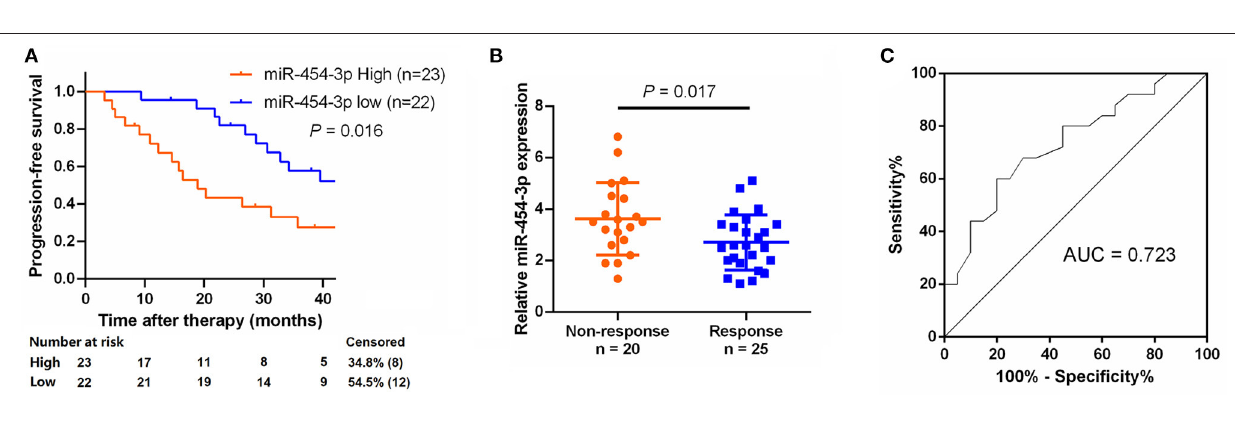
FIGURE 7 | Expression of miR-454-3p correlates with PFS in oxaliplatin treated colorectal cancer patients. (A) Colorectal cancer patients who received oxaliplatin-based chemotherapy were separated into groups based on low or high miR-454-3p expression. Kaplan–Meier survival curves were used to compare the PFS between the two groups. (B) Expression of miR-454-3p in patients who responded to oxaliplatin ( n = 25) and who did not respond ( n = 20) to oxaliplatin was compared using the two-tailed Student t test. U6 small nuclear RNA was used as an internal control. (C) ROC curve for patients responding vs. non-responding